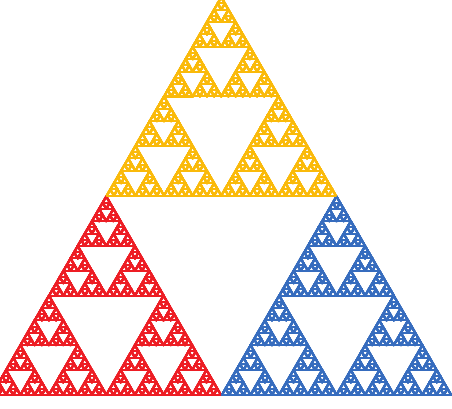
Figure 1. The classical Sierpinski